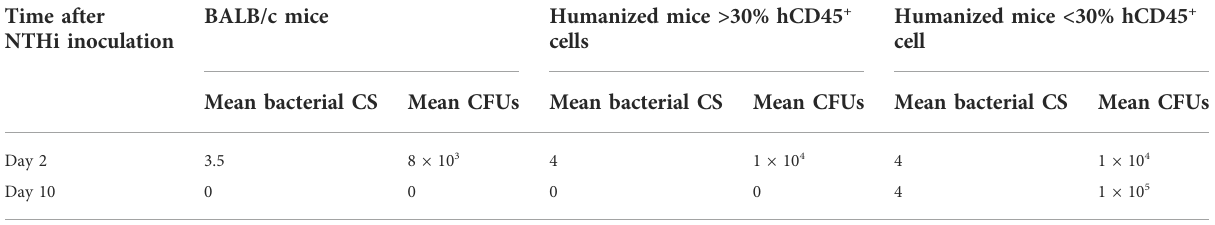
Bacterialcolonizationofchocolate-agarplateswasevaluatedusingasemi-quantitativemethodtogeneratecolonizationscore(CS)asfollows:0indicatednocolony-formingunit(CFU)on theplate;1indicatedCFUsinonequadrant;2indicatedCFUsintwoquadrants;3indicatedCFUsinthreequadrants;and4indicatedCFUsinallfourquadrantsontheplate.Atleast6ears were cultured for each time points of WT and humanized